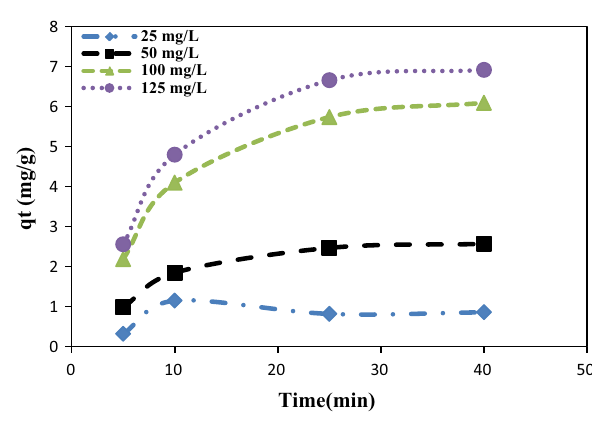
Fig. 8 Fitting of the nonlinear Lagergren model with the adsorption kinetic